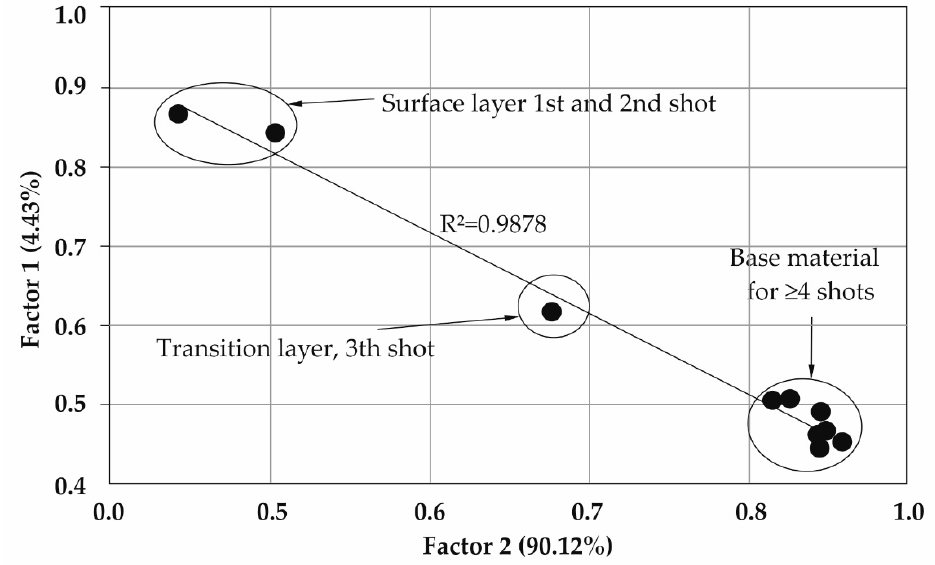
Figure 11. Factorial analysis of the LIBS spectra of a Ti6Al4V alloy sample.